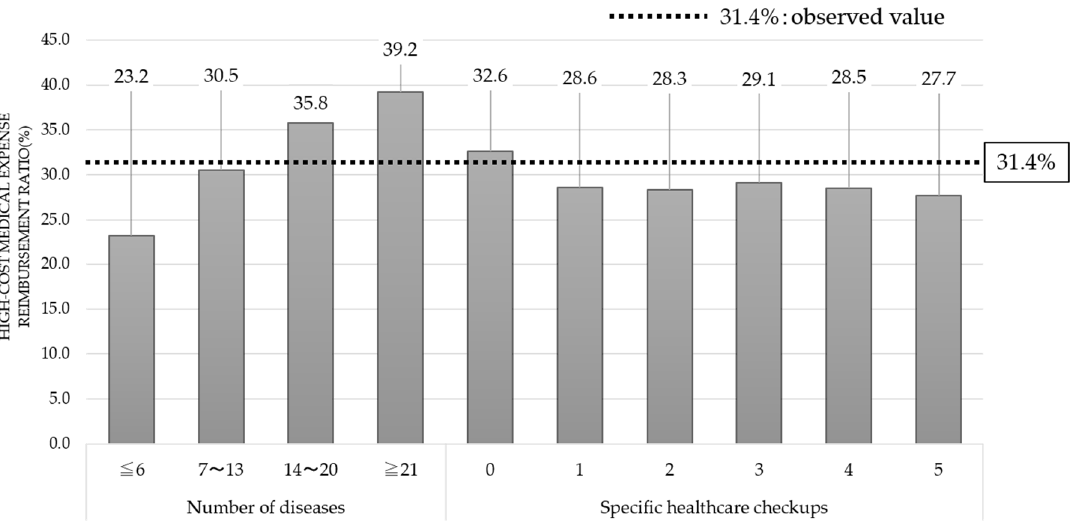
Figure 4. High-cost medical expense ratio (the number of diseases and specific healthcare checkups).